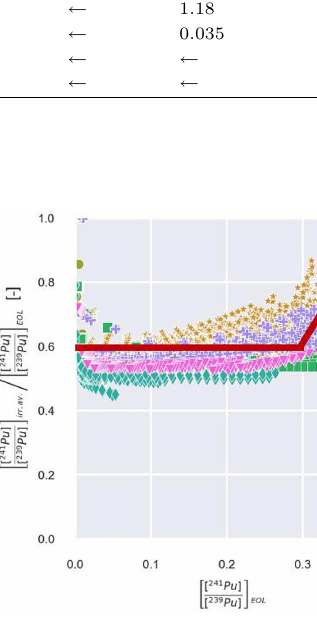
Fig. 4. Ratio of the irradiation-average 241 Pu-to- 239 Pu con- centration ratio for all cases of the assessment database, with its EOL value for uranium-based fuels, plotted as a function of the EOL concentration ratio. The red line is the approximation proposed in this work (Eq.